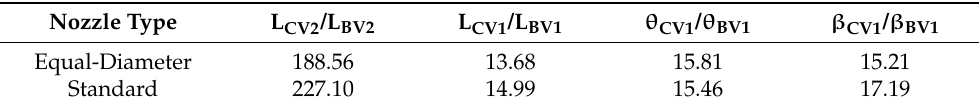
Table 1. Parameters of the jet outlet of the equal-diameter nozzle and the standard nozzle with a compressed air pressure of 212,782 Pa and a temperature of 303